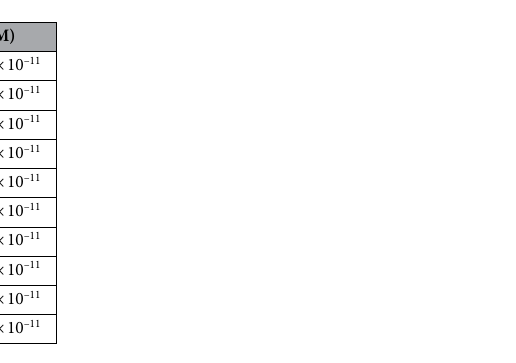
Figure 2. Selection of peptide barcodes. ( a ) Peak intensities of 838 candidate peptide barcodes analysed by liquid chromatography–tandem mass spectrometry (LC–MS/MS). Candidate peptide barcodes were selected using the yeast SRMAtlas. The vertical axis shows the sum of the intensities of each peptide obtained from three independent analyses. The intensity of each peptide was calculated as the sum of the peak areas of four transitions. The horizontal axis shows the number of corresponding proteins per cell calculated previously 35 . Blue dots indicate analysed peptides, and red dots indicate selected peptide barcodes among them. ( b ) Physiochemical properties of the selected 107 peptide barcodes. The hydropathicity (GRAVY) and isoelectric point (pI) of each peptide were mapped in a 2D map. ( c ) Physicochemical properties of nine representative peptide barcodes. The selected 107 peptide barcodes were classified into nine groups based on GRAVY and pI values, and 1 representative peptide was selected from each group. The left and right figures in parentheses indicate GRAVY and pI values, respectively. This figure was created using Illustrator CS2 (https:// www. adobe. com/).